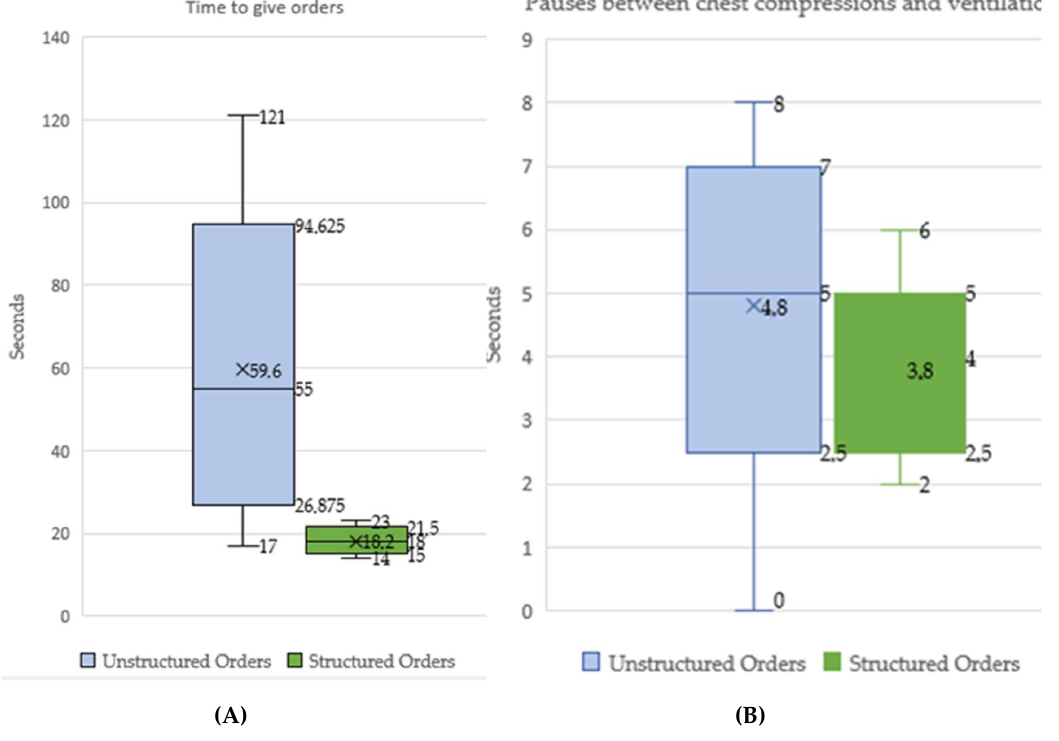
Figure 2. ( A ) Time needed to give orders. ( B ) Pauses between chest compressions and ventilations. The mean depth was 51.1 mm (SD 7.94) for EG, and 42.2 mm (SD 12.04) for the CG (Table